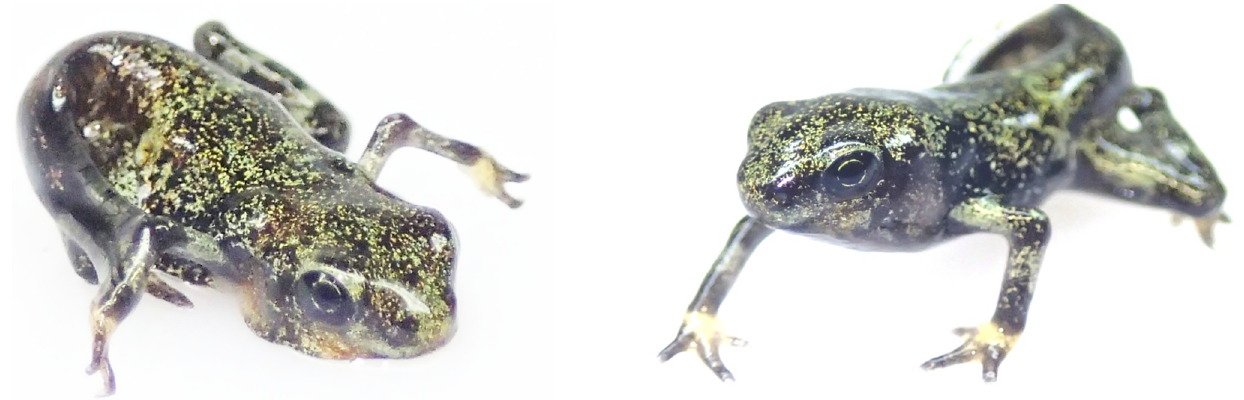
Fig 1. Atelopus varius metamorphs: Typical spindly leg syndrome posture (left) and normal, healthy posture (right).